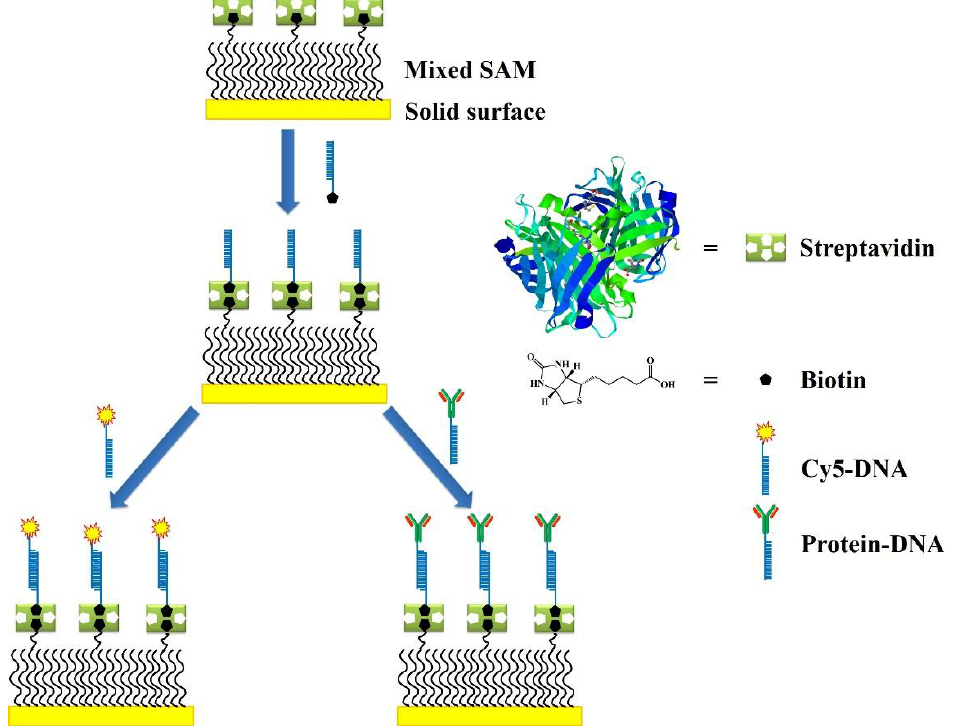
Figure 4. Immobilization of DNAs by using streptavidin-biotin